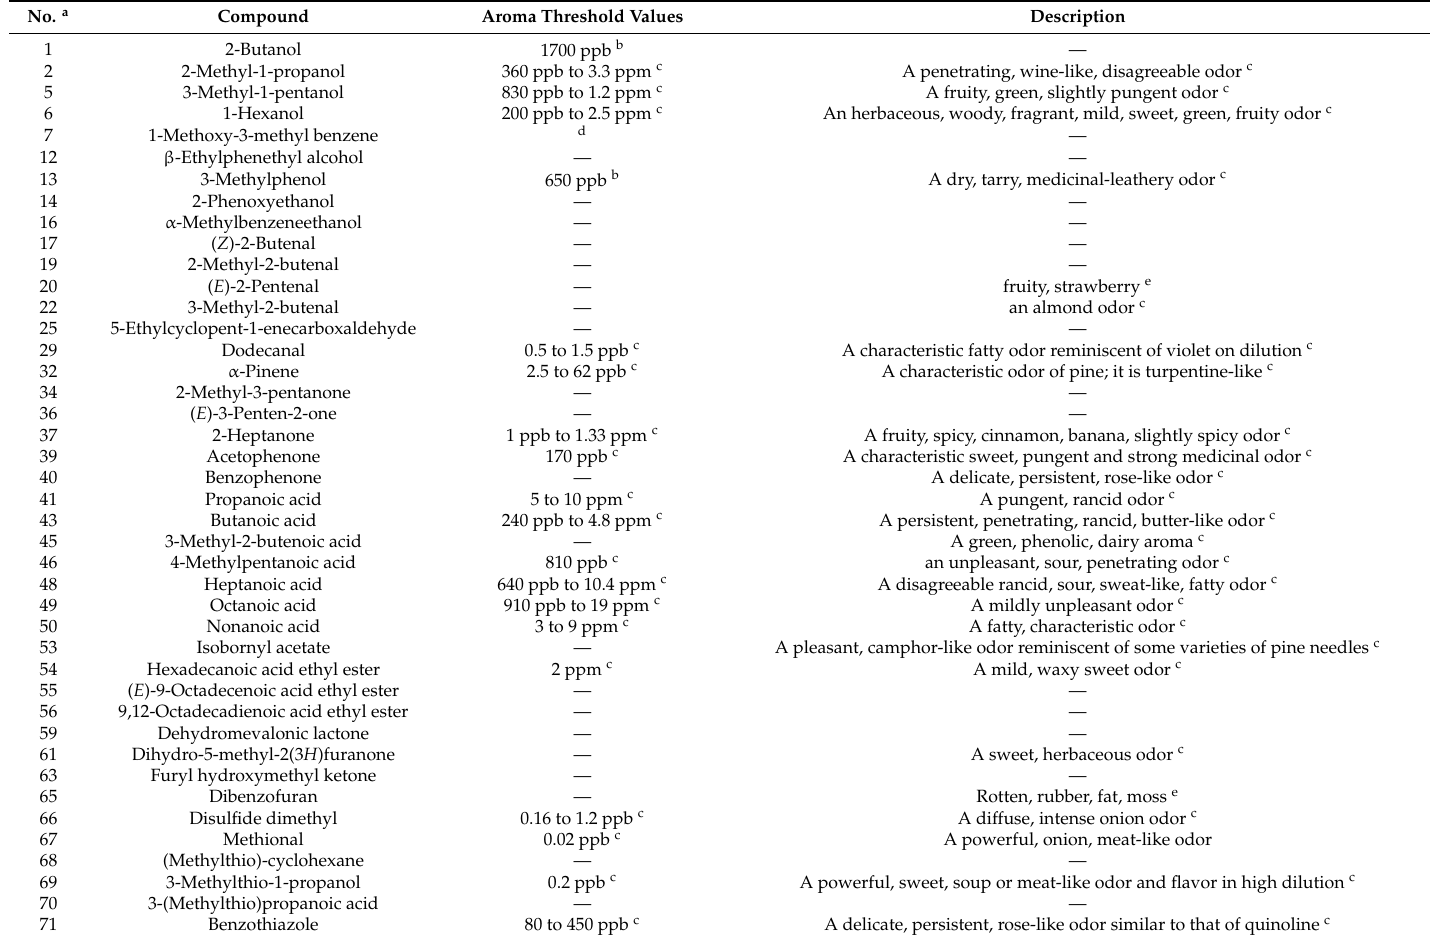
Table 2. Aroma description and threshold values of the major volatile compounds in BT and WT with a significant difference and the compounds that can be detected in BT, but not in WT, or vice versa